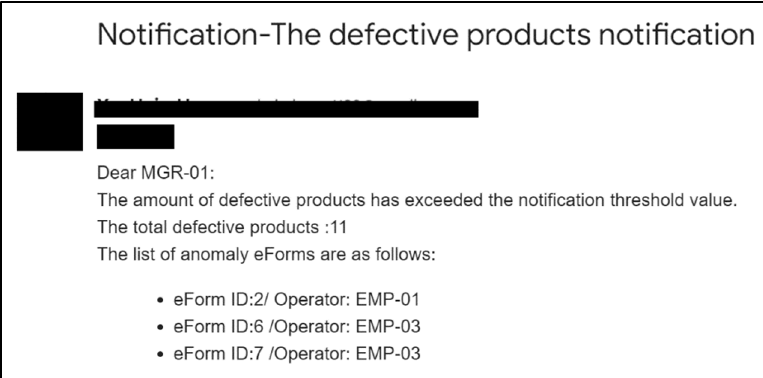
Figure 11. The results of the resource pool.